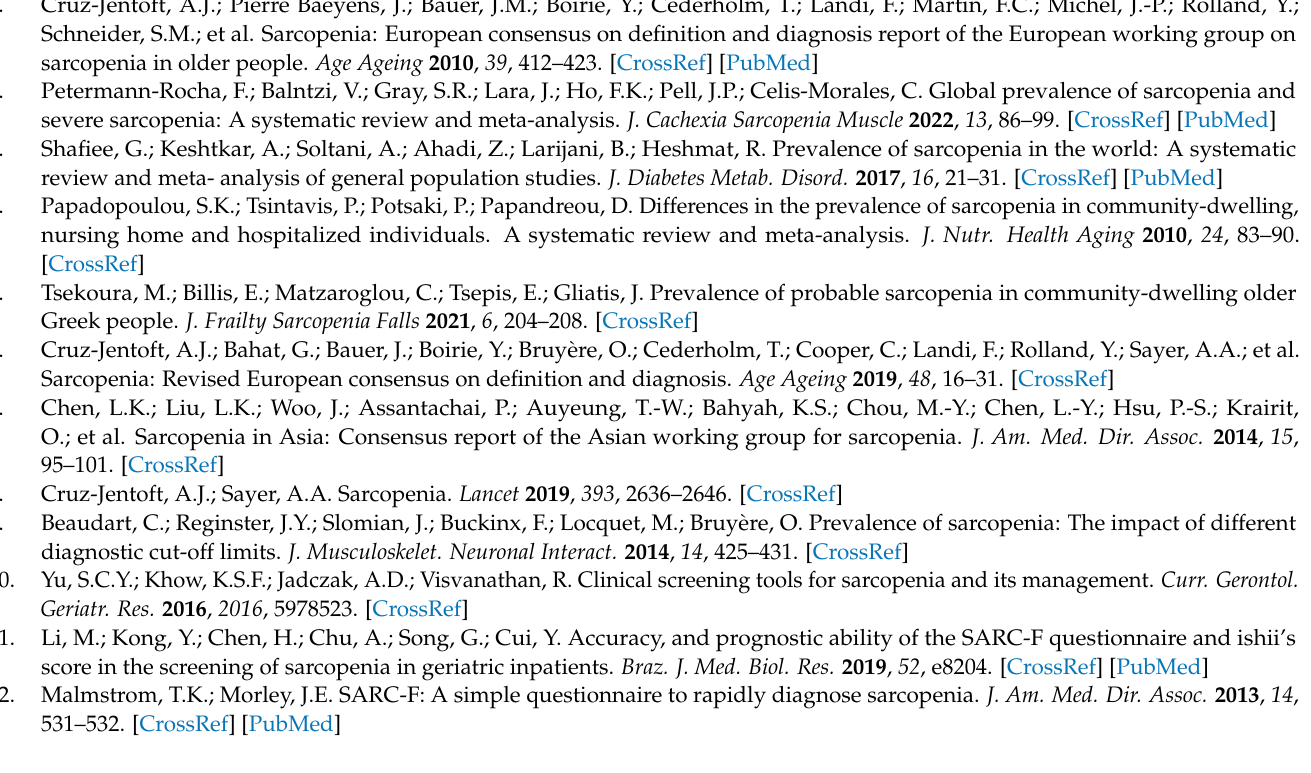
Table S3: SARC-F